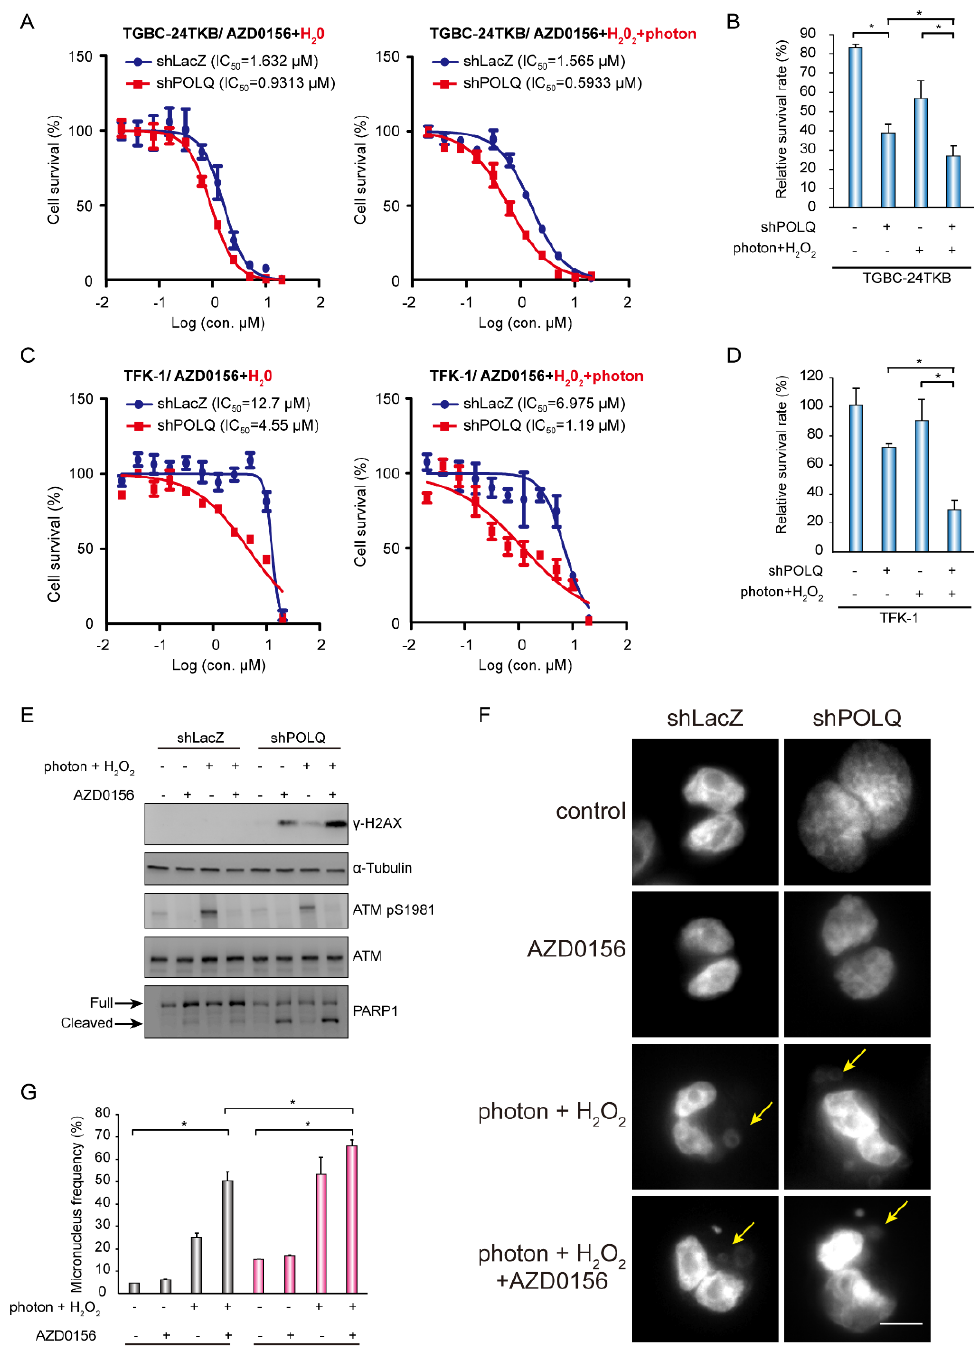
Figure 4. DNA damage enhances the effect of AZD0156-mediated cell death in DNA polymerase θ -depleted BTC cells. ( A ) Cell viability in various concentrations of AZD0156. TGBC-24TKB cells receiving shRNAs specific to DNA polymerase θ (shPOLQ) or LacZ (shLacZ) were treated with 5 Gy photons, and 1 μM H2O2 for 2 h before AZD0156 addition. The values (means ± SD) are from two data points, and are expressed as a percentage relative to that of the cells without AZD0156 treatment. The IC 50 values for AZD0156 in the cell lines are shown in each panel. ( B ) The relative cell viability in 0.5 μM AZD0156 for 72 h. TGBC-24TKB cells receiving shRNAs specific to DNA polymerase θ (shPOLQ+) or LacZ (shPOLQ–) were treated with 5 Gy photons and 1 μM H 2 O 2 for 2 h before AZD0156 addition. The values (means ± SD) are from three independent experiments, and are expressed as a percentage relative to that of the cells without AZD0156, 5 Gy photons, and 1 μM H 2 O 2 treatment; * p < 0.05 by Student’s t -test. ( C ) Cell viability in various concentrations of AZD0156. TFK- 1 cells receiving shRNAs specific to DNA polymerase θ (shPOLQ) or LacZ (shLacZ) were treated with 5 Gy photons and 1 μM H 2 O 2 for 2 h before AZD0156 addition. The values (means ± SD) are from two data points, and are expressed as a percentage relative to that of the cells without AZD0156 treatment. The IC 50 values for AZD0156 in the cell lines are shown in each panel. ( D ) The relative cell viability in 2.5 μM AZD0156 for 72 h. TGBC-24TKB cells receiving shRNAs specific to DNA polymerase θ